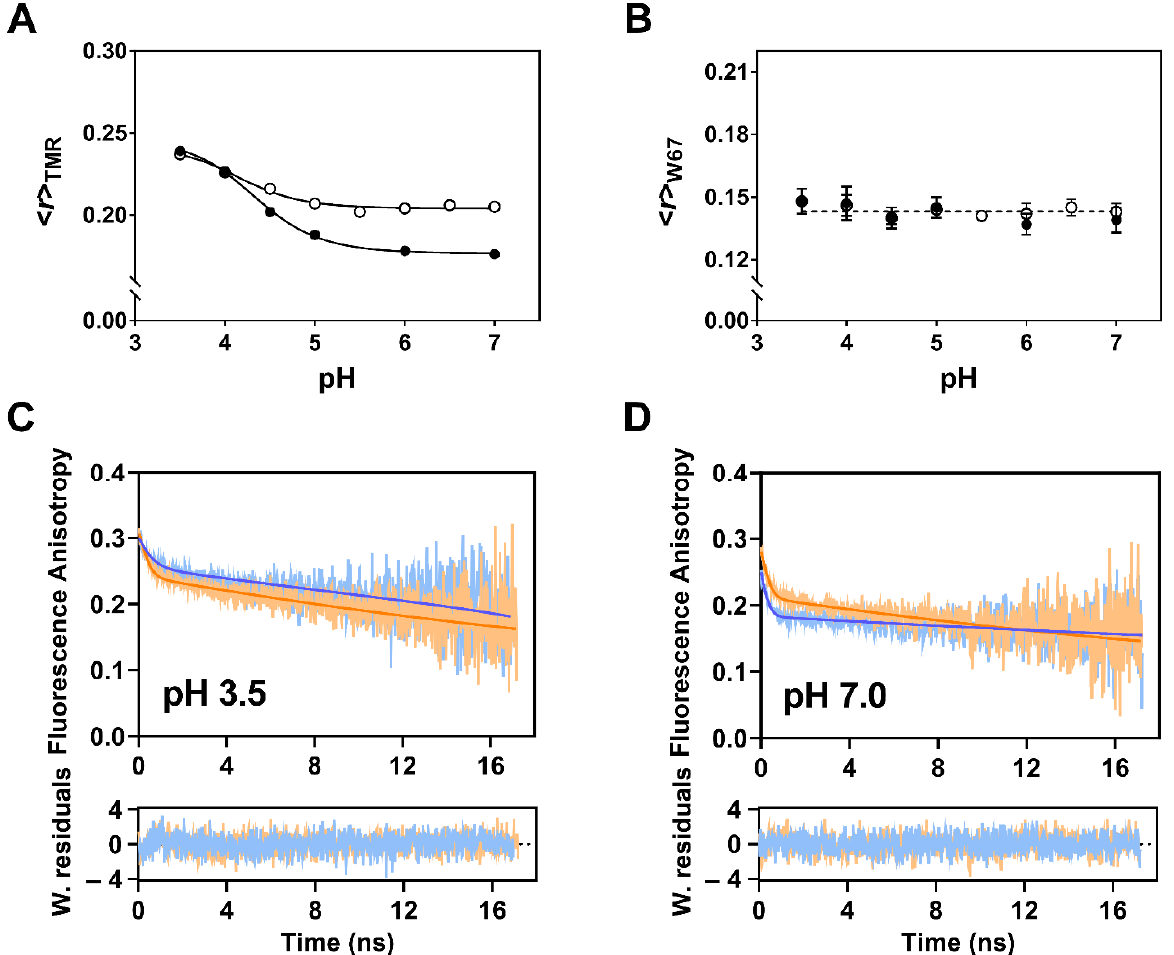
Figure 7. Impact of C-terminal truncation on the conformational dynamics of the KcsA inner gate. ( A , B ) The steady-state fluorescence anisotropy of the ( A ) conjugated TMR, <r> TMR , and ( B ) W67, <r> W67 , reporters were measured for the full- length (FL, ● ) and proteolytically cleaved ( Δ 125, ○ ) TMR-labeled G116C W67 KcsA (D:P = 0.60). The measuring conditions were as in Figure 6. ( A ) The fits of a Hill equation to the sigmoidal data (solid lines) yielded a p K a (FL)= 4.34 ± 0.04 and p K a ( Δ 125) = 4.3 ± 0.1. ( B ) The dashed line corresponds to an average < r > W67 = 0.142 ± 0.003 ( n = 14). ( C , D ) Anisotropy decays of TMR conjugated to G116C W67 KcsA (D:P 0.60) performed at ( C ) pH 3.5 and ( D ) 7.0 for the full-length (FL, blue data) and proteolytically cleaved ( Δ 125, orange data) protein ( λ ex = 488 nm λ em = 575 nm). The solid lines are the best fits of a double exponential function to the experimental data and the fitted parameters are summarized in Table 2. The bottom panels display the weighted residuals (W. residuals) from the fittings. The buffers contained 5 mM DDM and 200 mM KCl ( T = 25 °C).